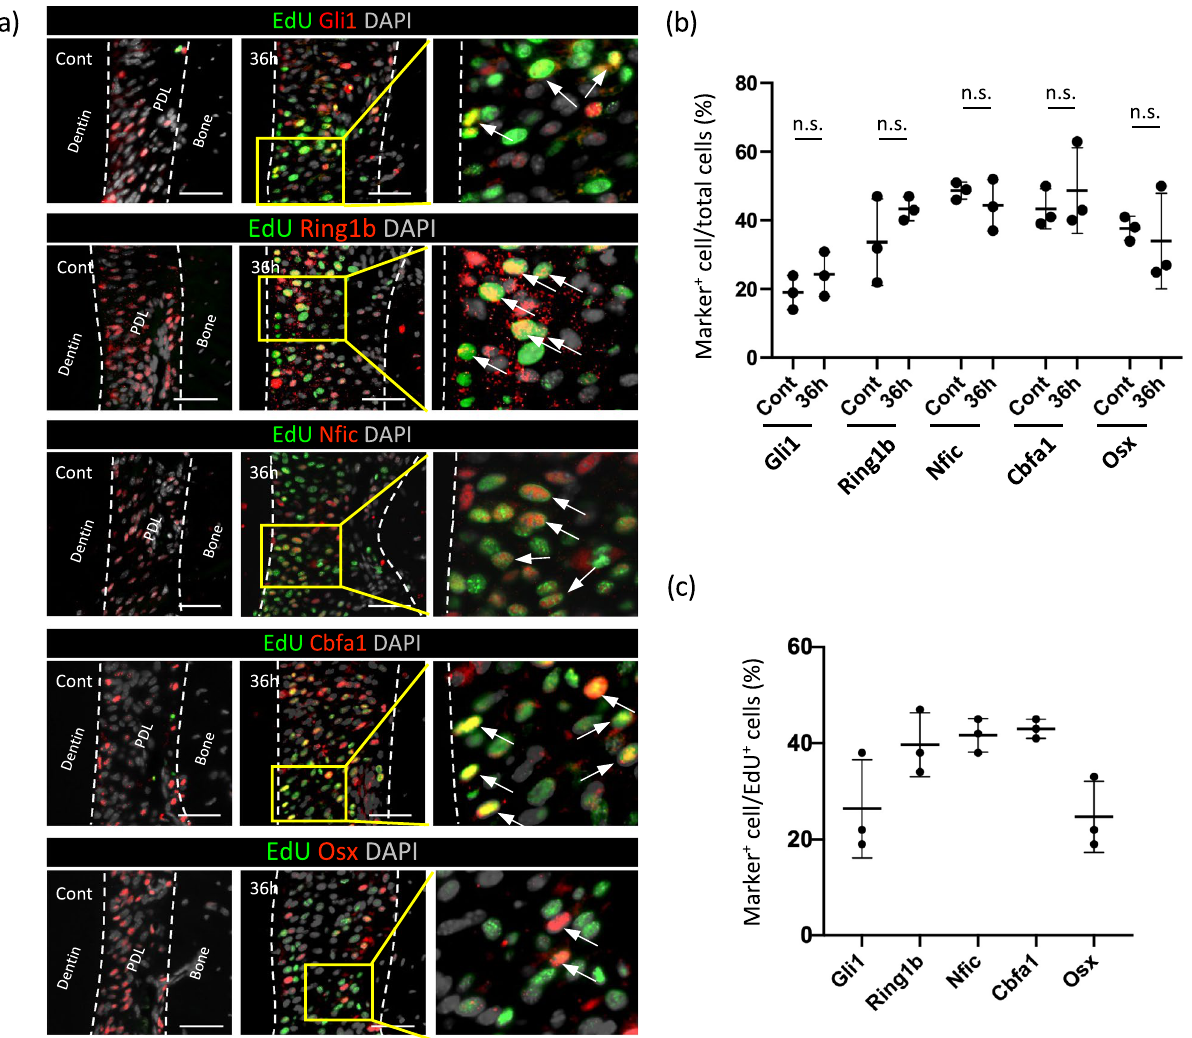
Figure 3. Characterization of proliferative cells during OTM. ( a ) Marker expression (red) in EdU + proliferating cells (green) after 36 h of OTM. The endogenous expression of each marker is shown in the control. Marker + cells among proliferating cells are indicated by arrows. Bar: 50 μm. ( b ) Ratio of marker + cells among total PDL cells between control and at 36 h of OTM were compared. OTM did not significantly affect the expression of the markers analyzed. ( c ) Percentage of marker + cells among the EdU + proliferating cells at 36 h of OTM. Proliferating cells expressed a diverse range of